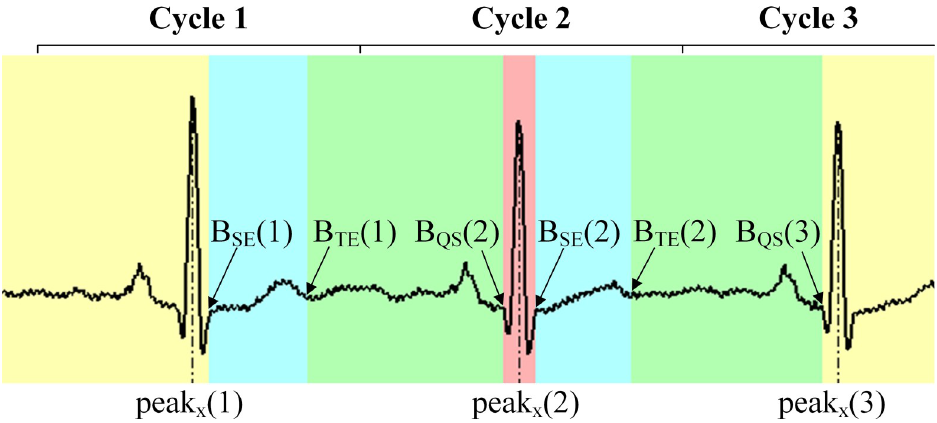
Fig 2. Different regions and boundaries of an ECG sequence with three R peaks (Data: s0459_re of patient233 from the PTB diagnostic ECG database). The blue regions indicate the ST-T region, the green regions indicate the R-P region, the red region indicates the QRS region, and the yellow regions indicate the H-T